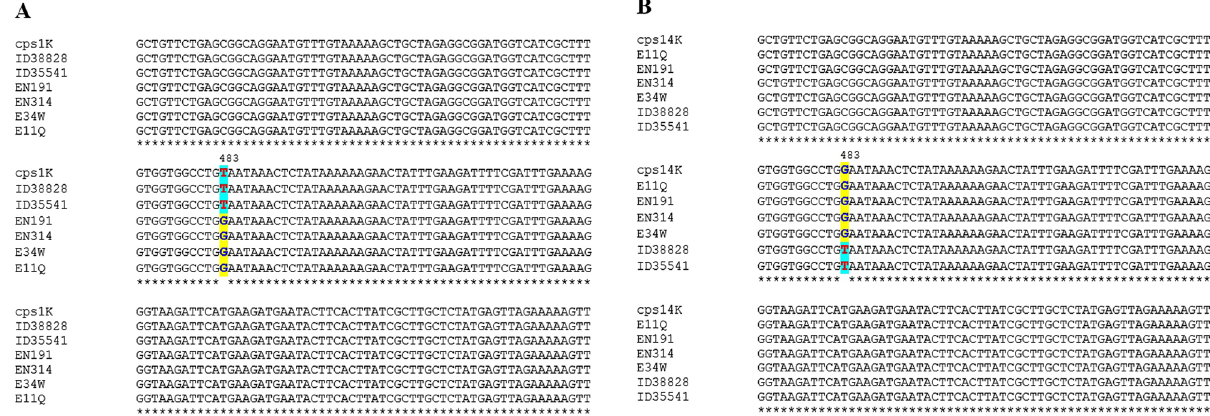
Figure 1. Alignment of cps1K ( A ) and cps14K ( B ) at the position of 483 to identify serotype 1 or 14 among the strains ID38828, ID35541, E11Q, E34W, EN191, and EN314. The alignment result indicated ID38828 and ID35541 were the serotype 1 and E11Q, E34W, EN191, and EN314 were the serotype